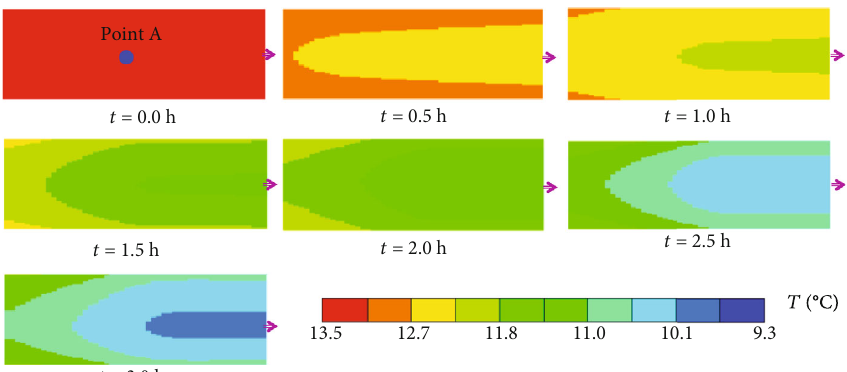
Figure 9: Temperature fi eld on the section a ‐ a (Figure 2) during the 3 rd depressurization when initial hydrate saturation is 75%. Point A represents the geometric core of the section a ‐ a